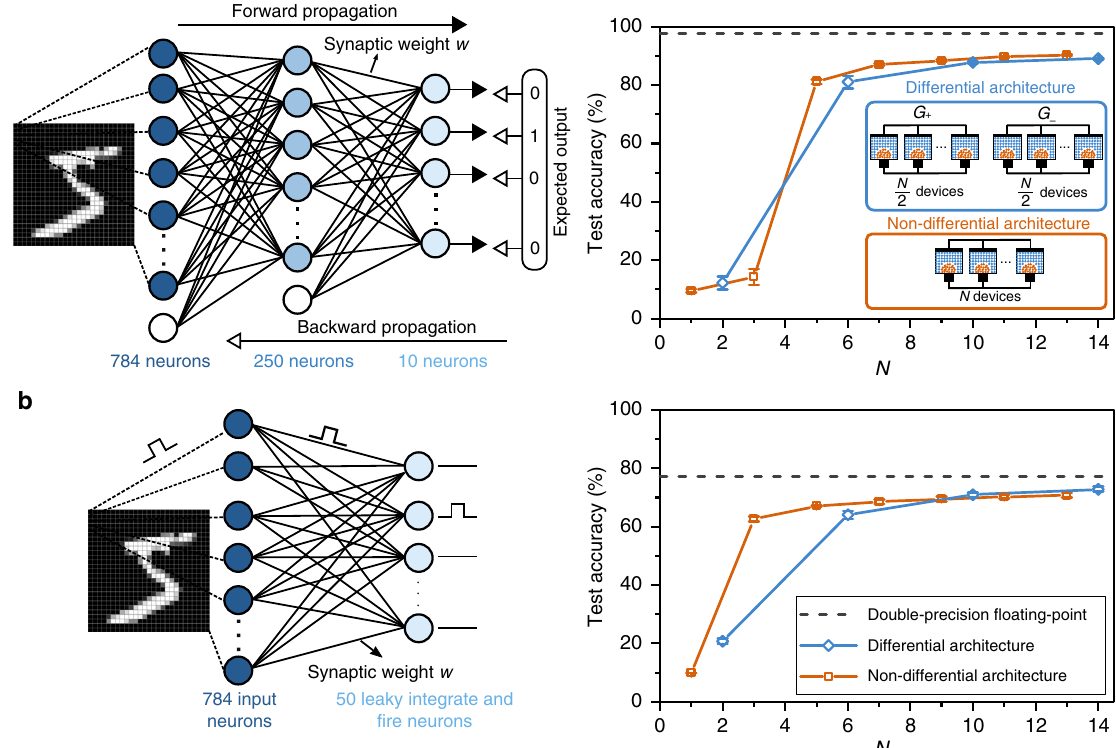
Fig. 4 Applications of multi-memristive synapses in neural networks. a An arti fi cial neural network is trained using backpropagation to perform handwritten digit classi fi cation. Bias neurons are used for the input and hidden neuron layers (white). A multi-memristive synapse model based on the nonlinear conductance response of PCM devices is used to represent the synaptic weights in these simulations. Increasing the number of devices in multi-memristive synapses (both in the differential and the non-differential architecture) improves the test accuracy. Simulations are repeated for fi ve different weight initializations. The error bars represent the standard deviation (1 σ ). The dotted line shows the test accuracy obtained from a double-precision fl oating-point software implementation. b A spiking neural network is trained using an STDP-based learning rule for handwritten digit classi fi cation. Here again, a multi- memristive synapse model is used to represent the synaptic weights in simulations where the devices are arranged in the differential or the non-differential architecture. The classi fi cation accuracy of the network increases with the number of devices per synapse. Simulations are repeated for fi ve different weight initializations. The error bars represent the standard deviation (1 σ ). The dotted line shows the test accuracy obtained from a double-precision